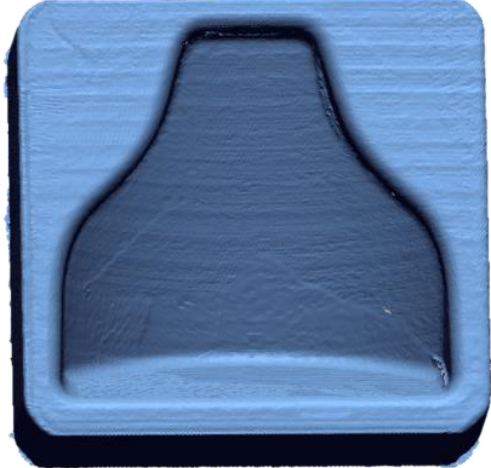
Figure 7. Cloud of point of the first mold.